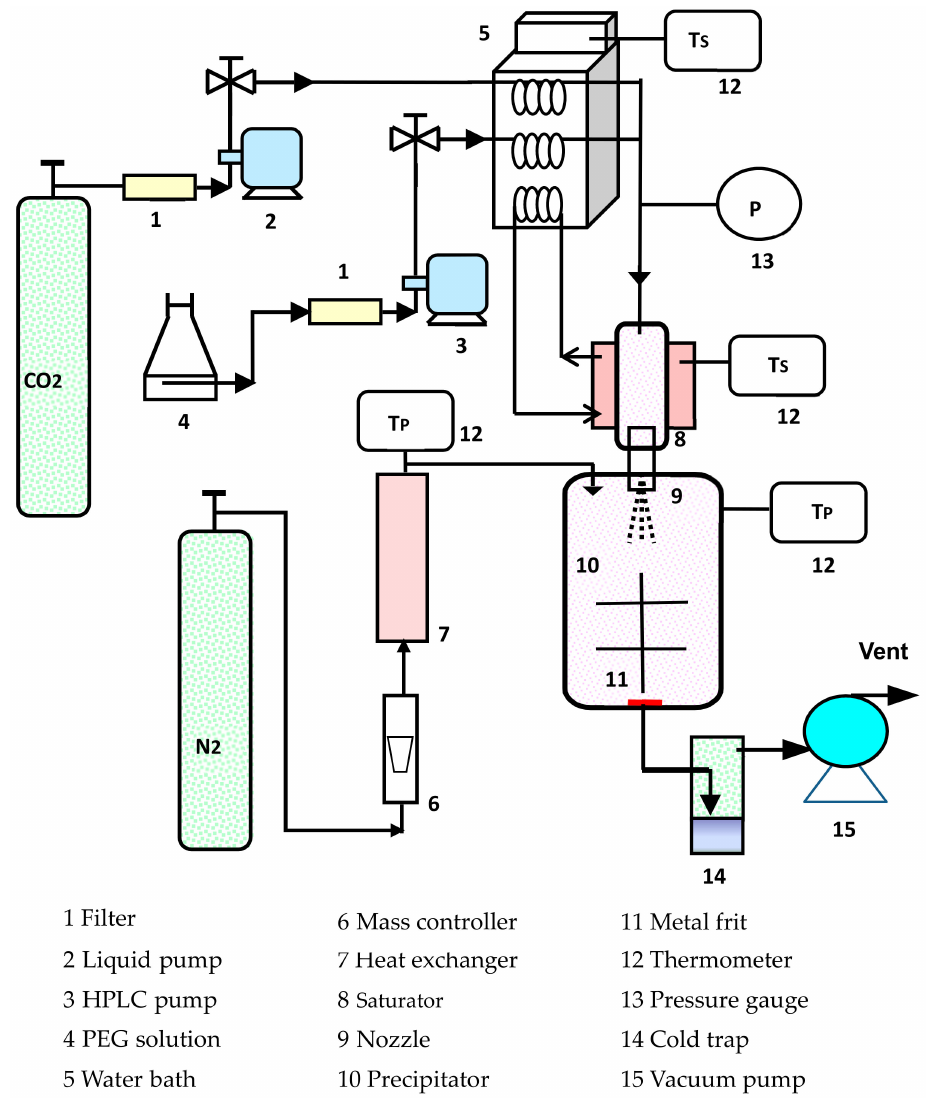
Figure 12. Apparatus of low-temperature supercritical assisted atomization